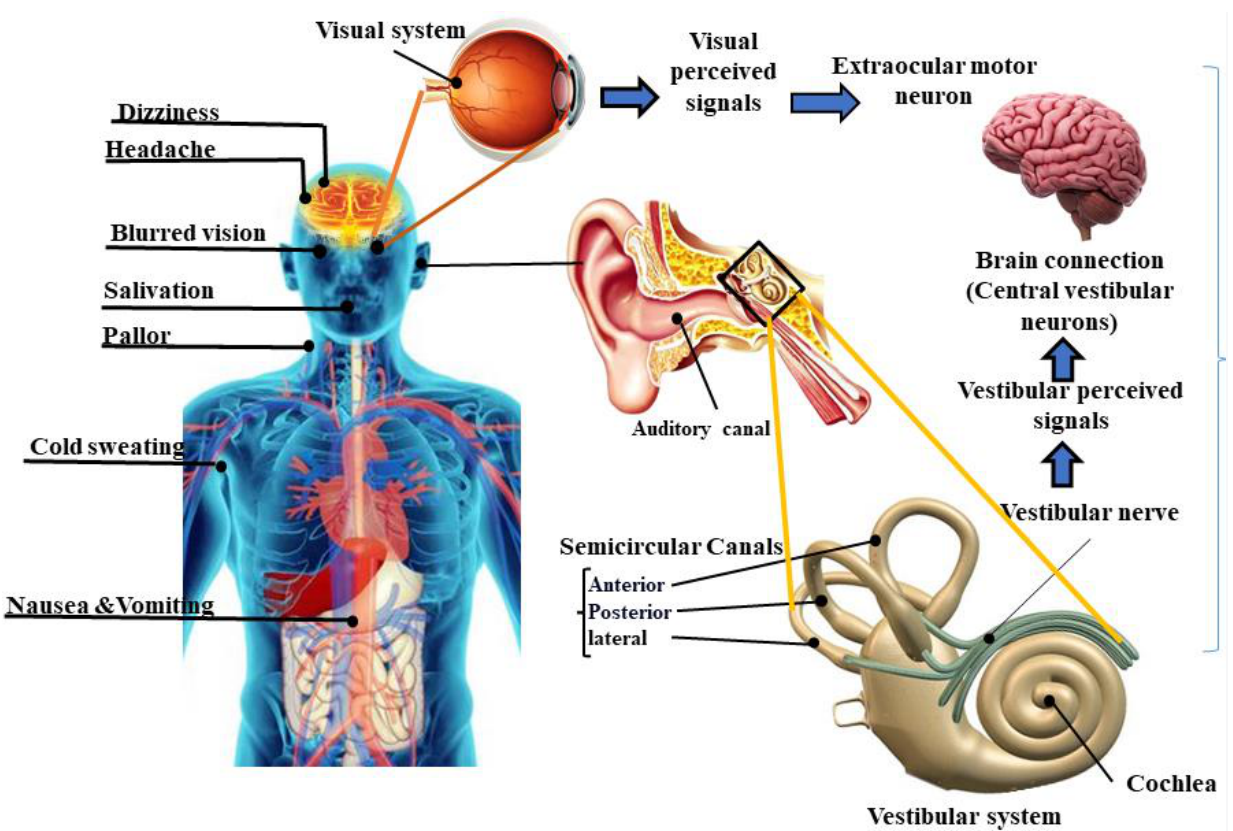
Figure 2. The vestibular system within the inner ear, transfers signals and information about perceived motion, spatial orientation, and head position to the brain. On the other hand, if the brain perceives and provides different inputs to the visual system, therefore, unauthentic inputs from these organs become a stimulus to trigger symptoms of MS.